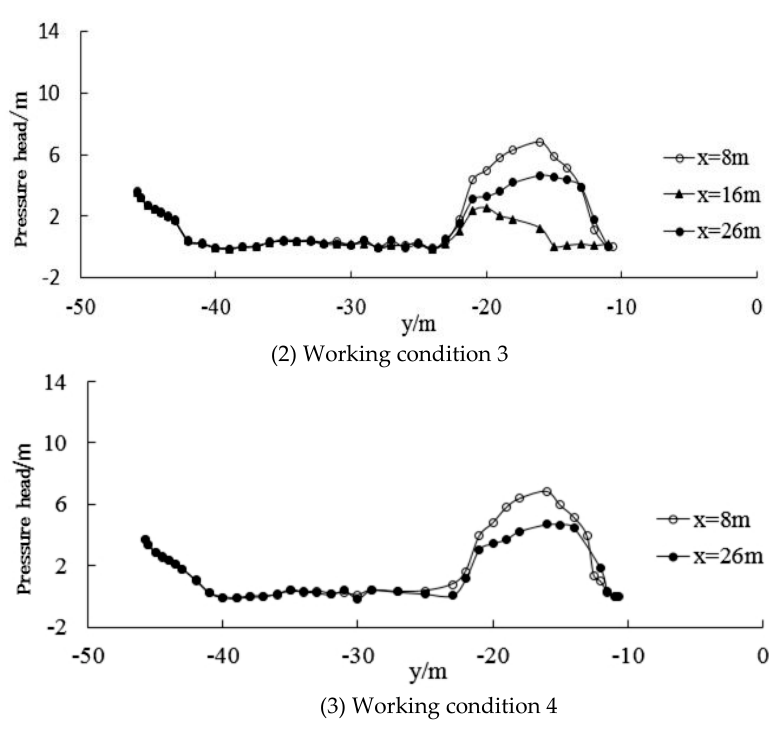
Figure 15. Surface pressure distribution on the spillway wall under different working conditions.